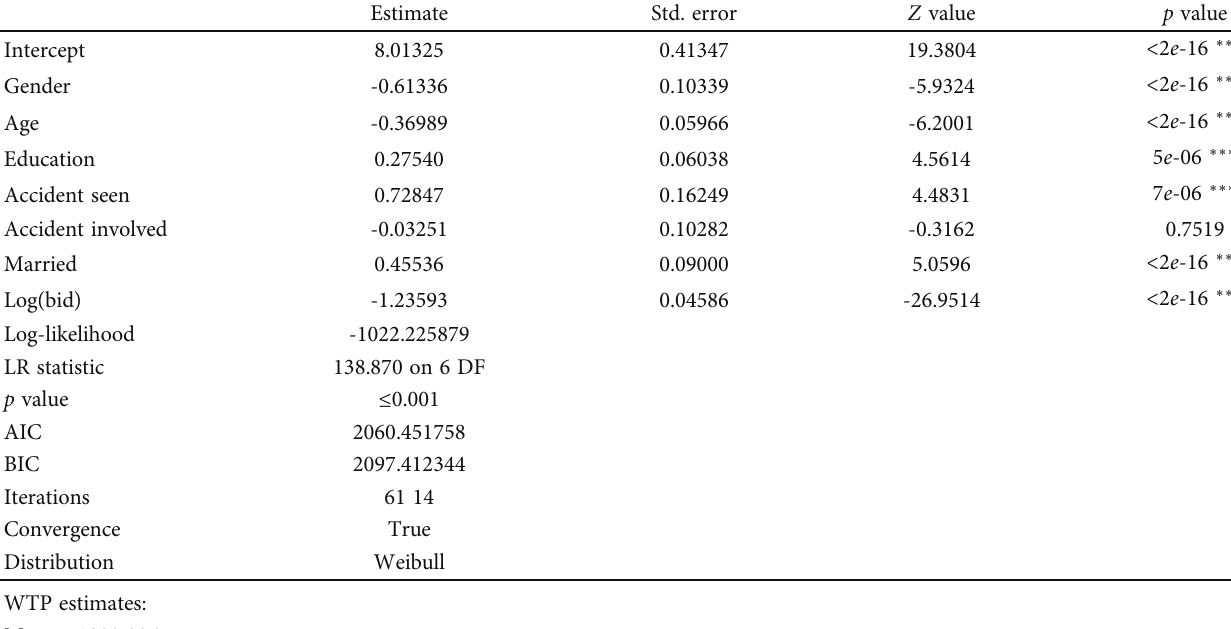
Table 10: Parameter estimates of the Weibull model (source: authors).